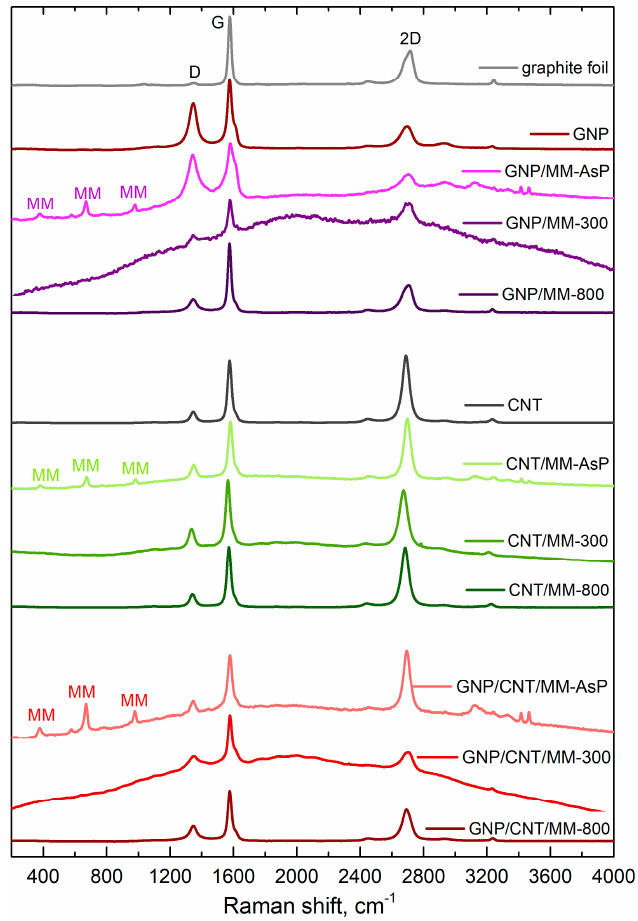
Figure 5. Raman spectra of composite powders. The main sp 2 -carbon Raman bands are assigned as D, G and 2D. The Raman bands derived from melamine are signed as MM.